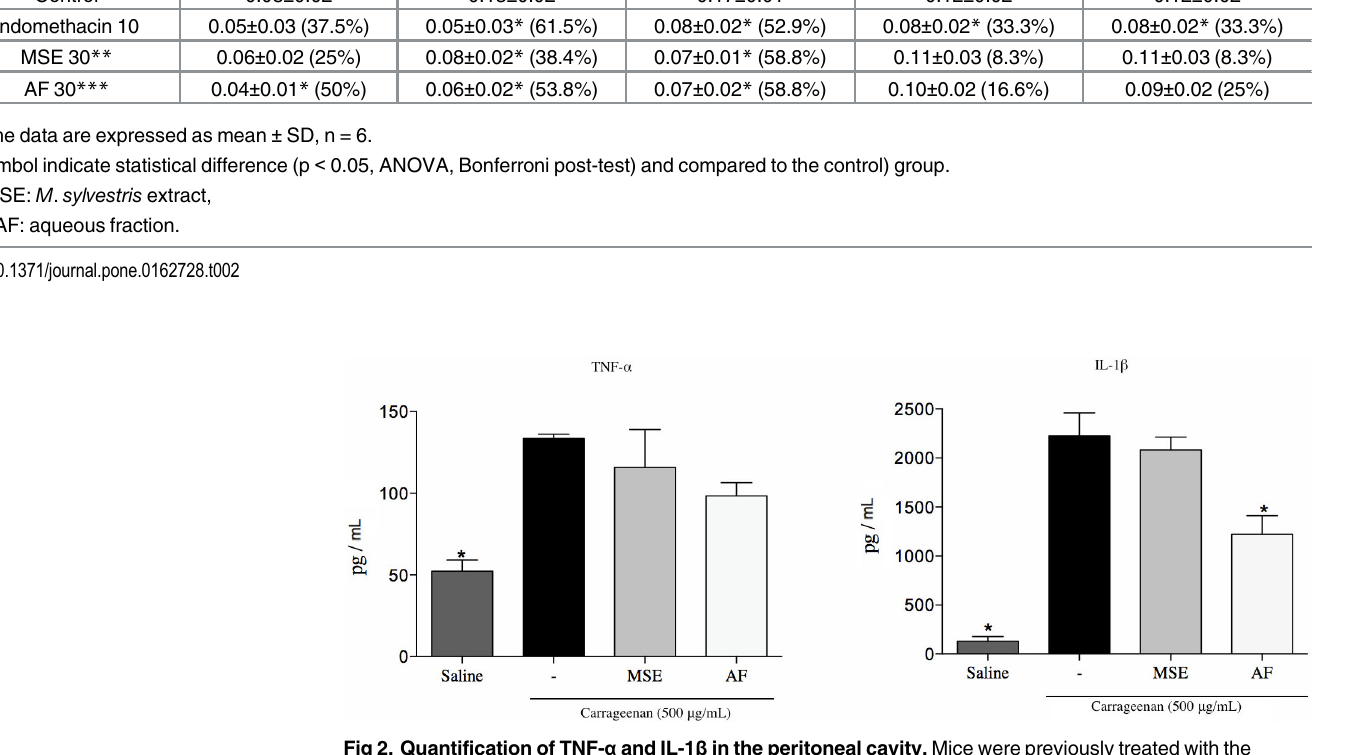
Fig 2. Quantification of TNF- α and IL-1 β in the peritoneal cavity. Mice were previously treated with the vehicle, the MSE and the AF at a dose of 30 mg/kg 1h before the carrageenan injection. Data are expressed as mean ± SD, n = 6. Symbols indicate statistical difference (p < 0.05, Dunnett ’ s test); * p < 0.05 compared to the carrageenan group.